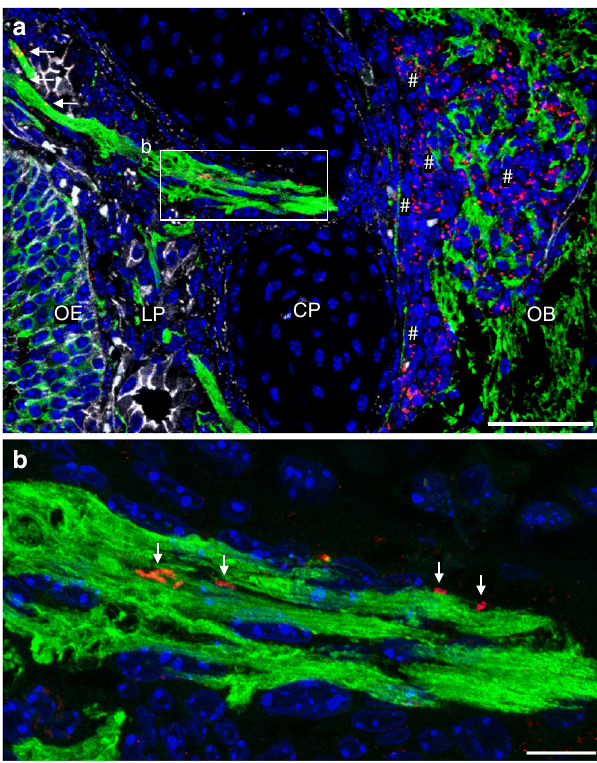
Fig. 4 Lm is situated in close proximity to olfactory nerves. Immunostaining of the olfactory tissue after i.n. infection of 1-day-old mice with 1 × 10 7 CFU Lm at 1 dpi. Olfactory bulb (OB), cribriform plate (CP), lamina propria (LP), and olfactory epithelium (OE). For IHC, sections were stained for Lm (red), the neuronal marker β -tubulin III (green), the tight-junction marker β - catenin (white) and DNA (DAPI, blue). a Sagittal view of the olfactory tissue. Bacteria are found associated with nerves in the LP (white arrows) and the cribriform plate (framed insert) as well as within the CNS (white hash symbols) (scale bar 50 µ m). b Enlarged insert from a showing Lm (red, white arrows) in close proximity to axons (green) in the cribriform plate (scale bar 10 µ m). The images are representative of n = 8